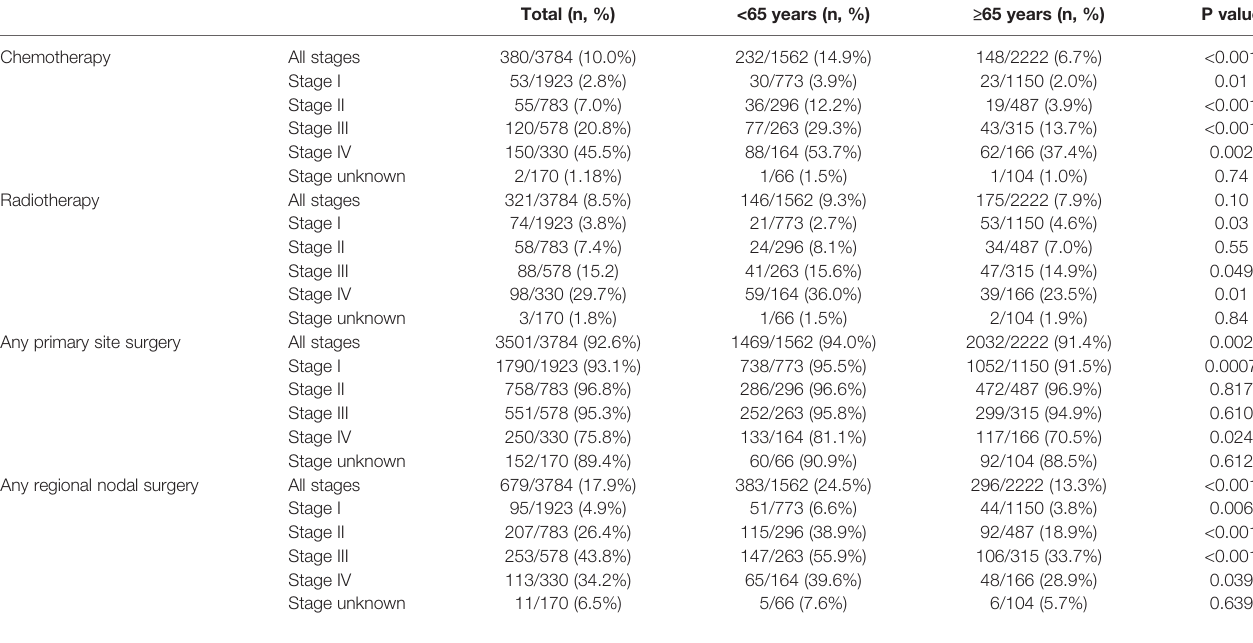
TABLE 4 | Treatment modalities by age and stage at